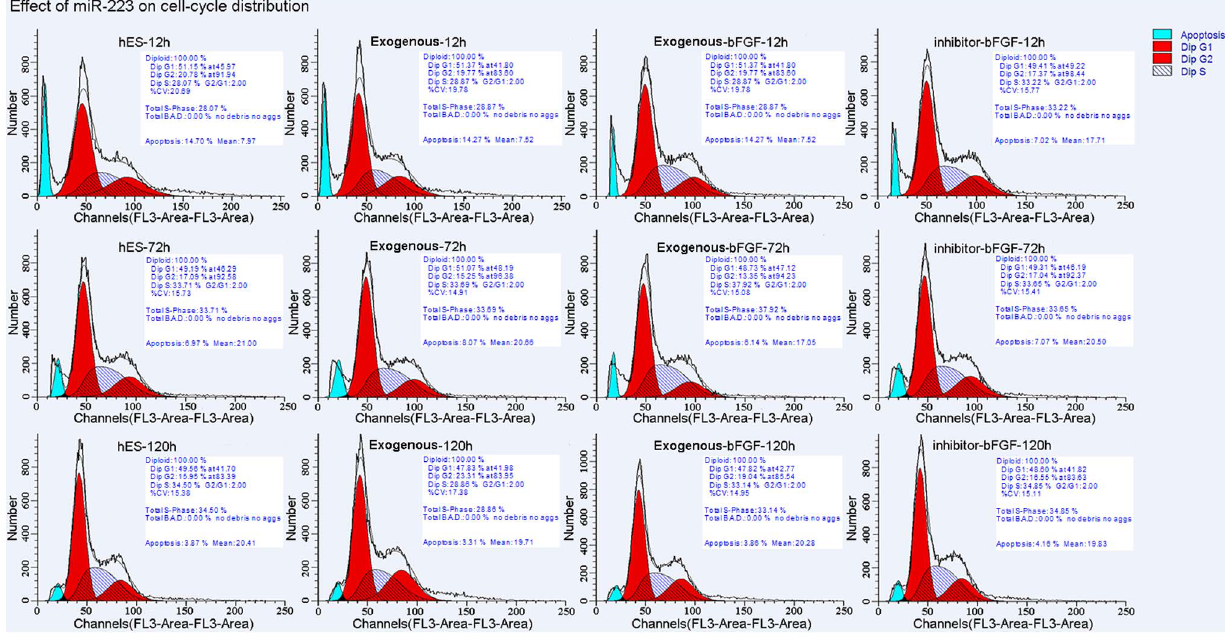
Figure 4. Effect of exogenous miR-223 on cell cycle progression. Cell cycle distribution for the indicated groups were assayed by flow cytometry 12 h, 72 h, and 120 h after the withdrawal of bFGF (n=3). Cells were treated with RNaseA and stained with PI. FACS analysis demonstrated that expression of exogenous miR-223, or an inhibitor of miR-223, does not affect cell cycle progression. The values shown are from experiments performed in triplicate 6 SD.